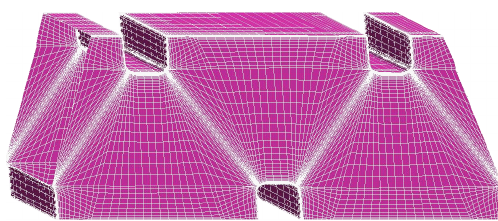
Figure 2: Details of the mesh arrangement on the channel